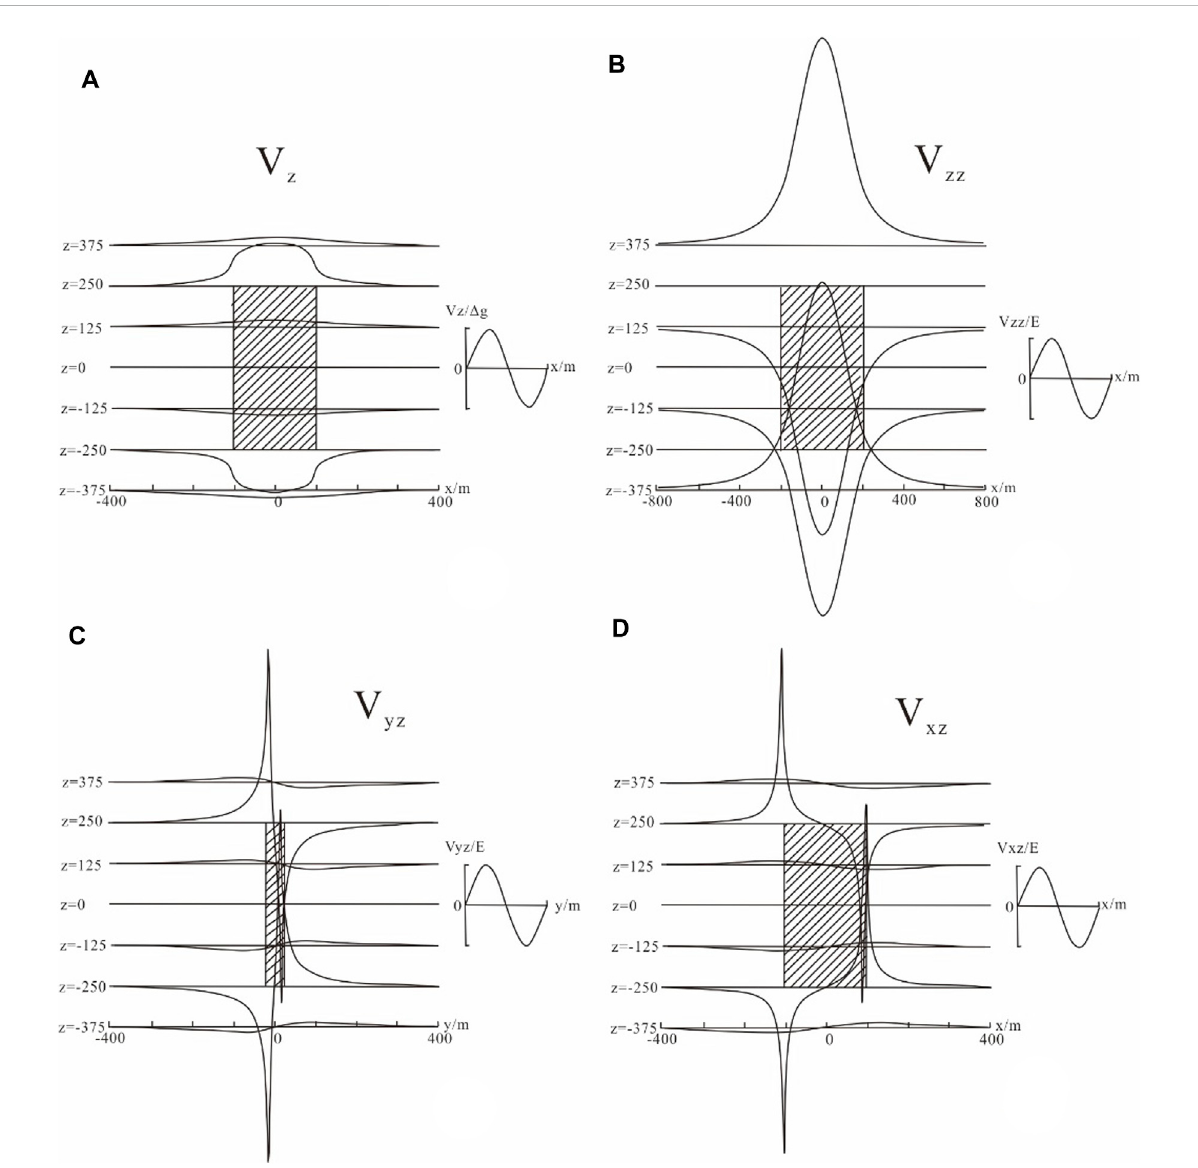
FIGURE 2 Model parameters: length 200 m, width 40 m, height 500 m, density difference 1.0 × 103 kg/m 3 (A) xoz section (B) xoz section (C) xoz section (D) yoz